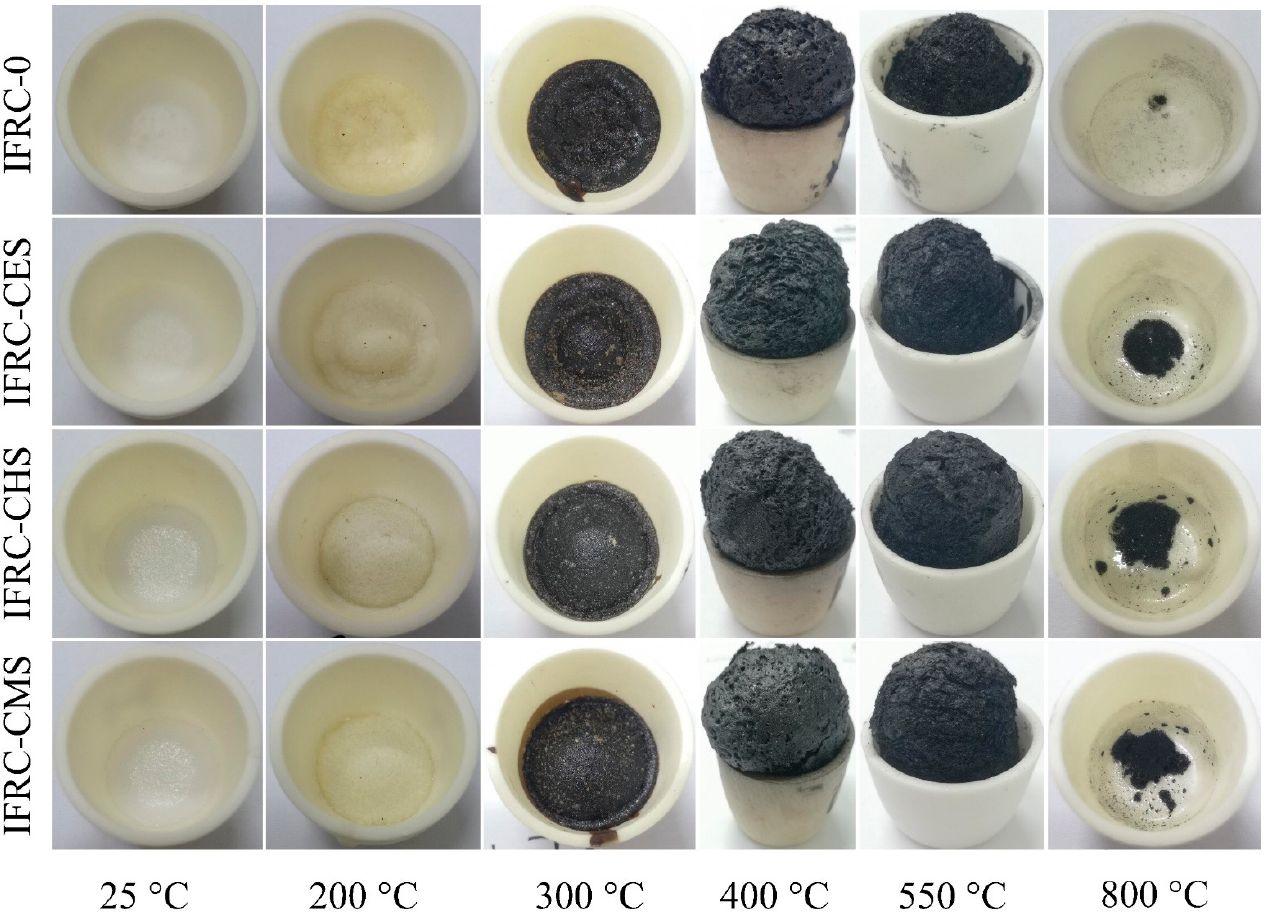
Figure 11. Photographs of char residues for IFRCs under different treatment temperatures.